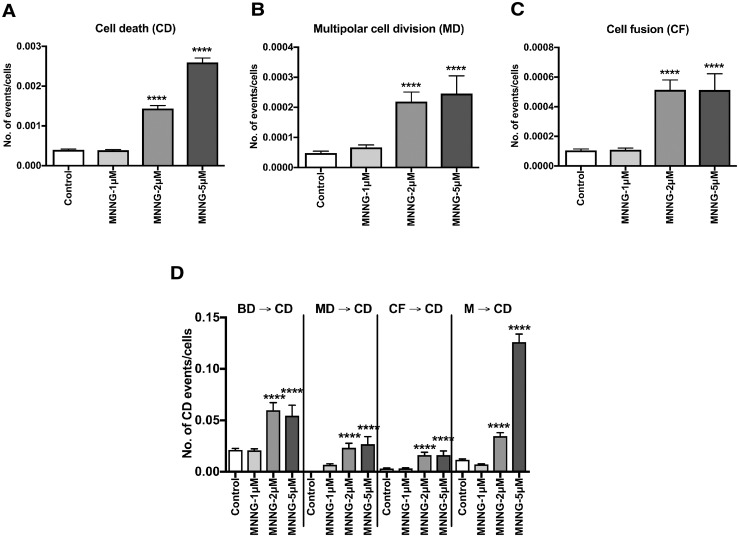
Numbers of CD, MD, and CF events in cells exposed to MNNG.Data in A-C were normalized by the total numbers of cells. The numbers of CD (A), MD (B), and CF (C) events that occurred in each cell lineage were determined using the cell lineage database. D. The numbers of CD events that occurred in each cell lineage following BD, MD, CF, or M are shown. If the event preceding M was MD or CF, the CD event following the M was included in MD → CD or CF → CD, respectively (see S6 Fig). A-D. One-way ANOVA (Tukey’s multiple comparison test) was performed. The statistical significance between Control with MNNG-1μM, MNNG-2μM, and MNNG-5μM are shown; ****p<0.0001. Results shown as the mean ± SEM. Sample sizes of Control, MNNG-1μM, MNNG-2μM and MNNG-5μM were 330, 317, 188 and 200, respectively.